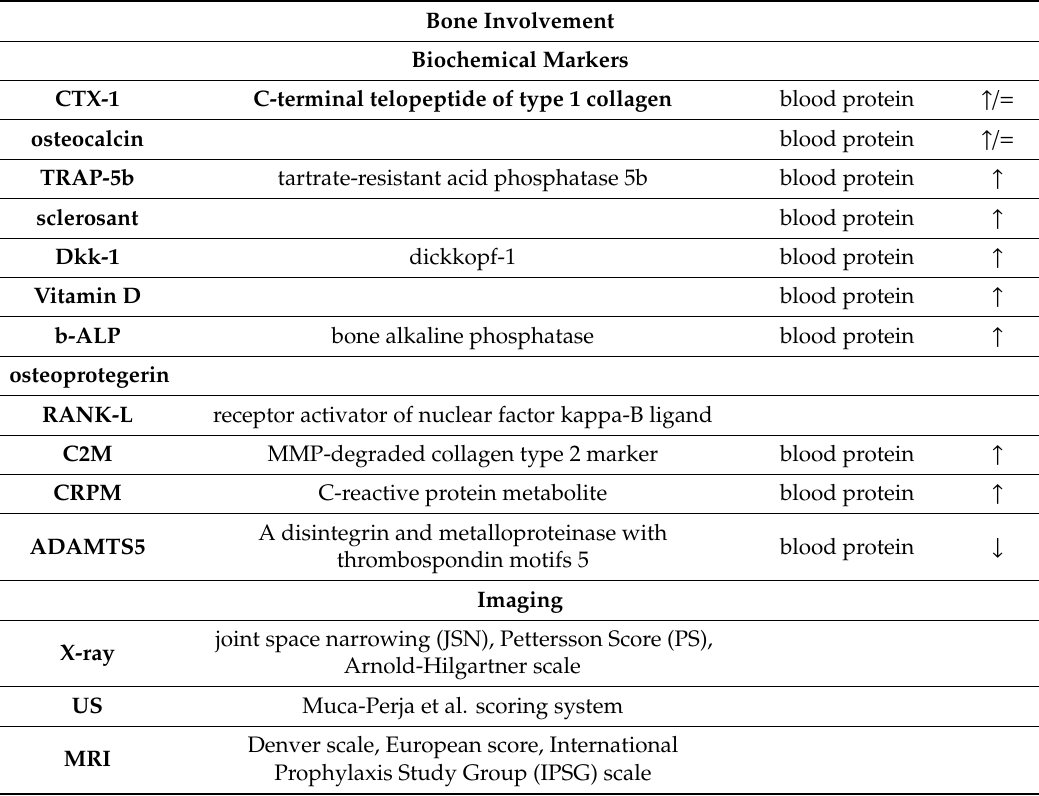
Table 5. Markers related to the bone involvement stage and their modifications in hemophilic arthropathy